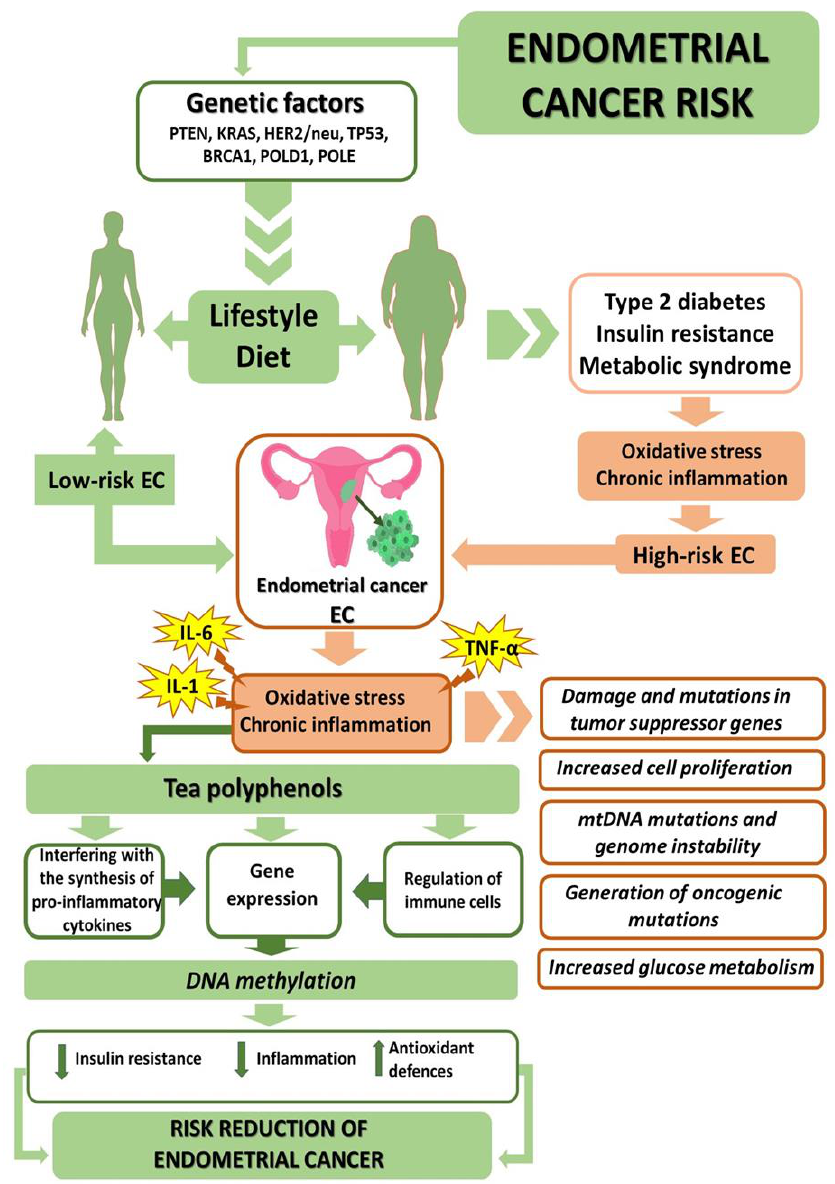
Figure 4. Beneficial effects of tea consumption on risk reduction in endometrial cancer. ↑ increased, ↓ decreased